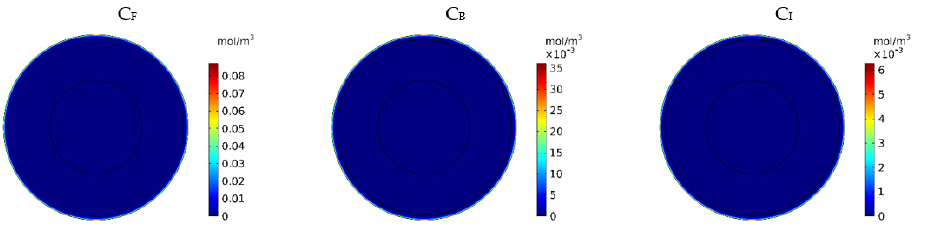
Figure 7. Contours of the free, bound, and internalized drug concentrations after 60 min of treat- ment.